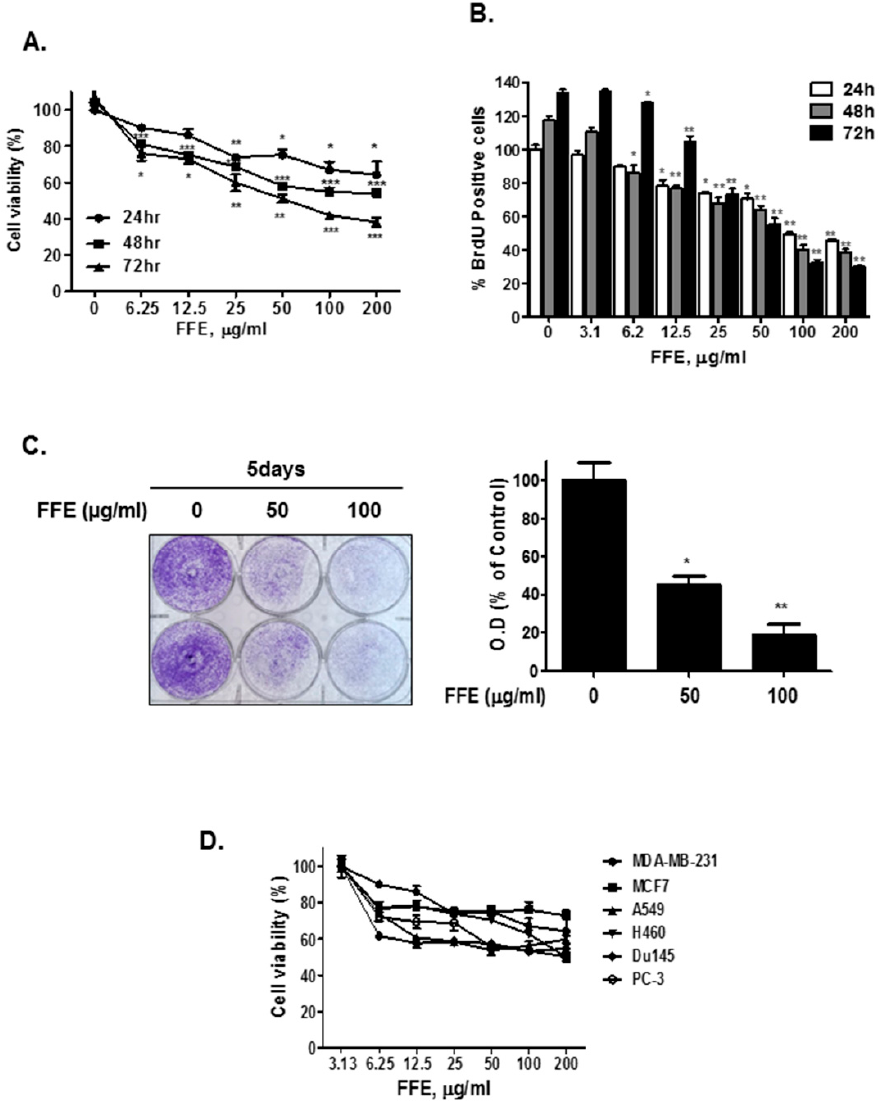
Figure 1. Cytotoxic and anti-proliferative effects of Fomes fomentarius ethanol extract (FFE). ( A ) Cytotoxic effect of time-dependent treatment of FFE in MDA-MB-231 cells. MDA-MB-231 cells treated with various doses of FFE for 24 h, 48 h, and 72 h. The cell viability valuated by MTT assay. Data represent mean ± SD, * p < 0.05, ** p < 0.01 and *** p < 0.001 compared with control. ( B ) MDA-MB-231 cells treated with various doses of FFE for 24 h, 48 h, and 72 h, then, cell proliferative rate measured using a bromodeoxyuridine (BrdU) proliferation ELISA kit. Data represent mean ± SD, * p < 0.05, ** p < 0.01 and *** p < 0.001 compared with control. ( C ) The anti-proliferation activity for long term treatment of FFE carried out by cell growth assay. MDA-MB-231 cells treated with various concentrations of FFE and maintained for 5 days. Cells stained with crystal violet and randomly chosen fields photographed and resolved in 70% EtOH and absorbance measured using a microplate reader. Data represent mean ± SD, * p < 0.05, ** p < 0.01 and *** p < 0.001 compared with control ( D ).